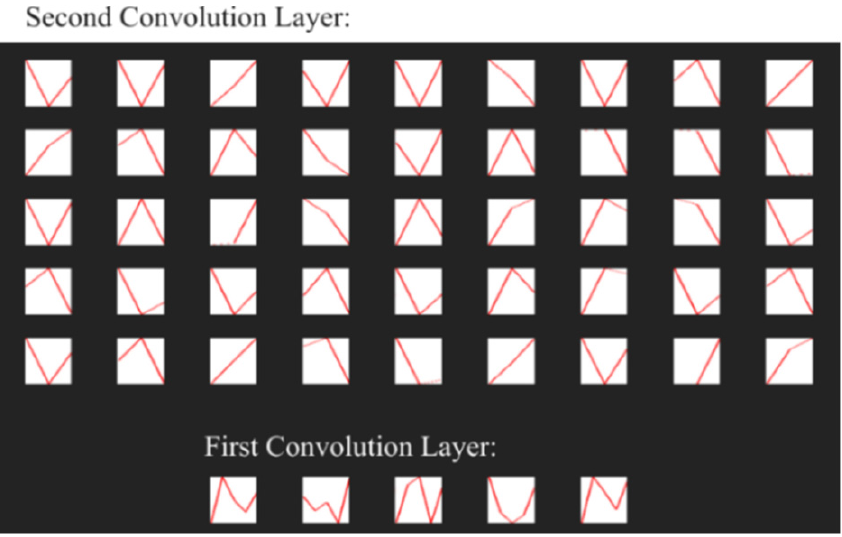
Figure 7. Example of obtained weight maps applied in the designed CNN.